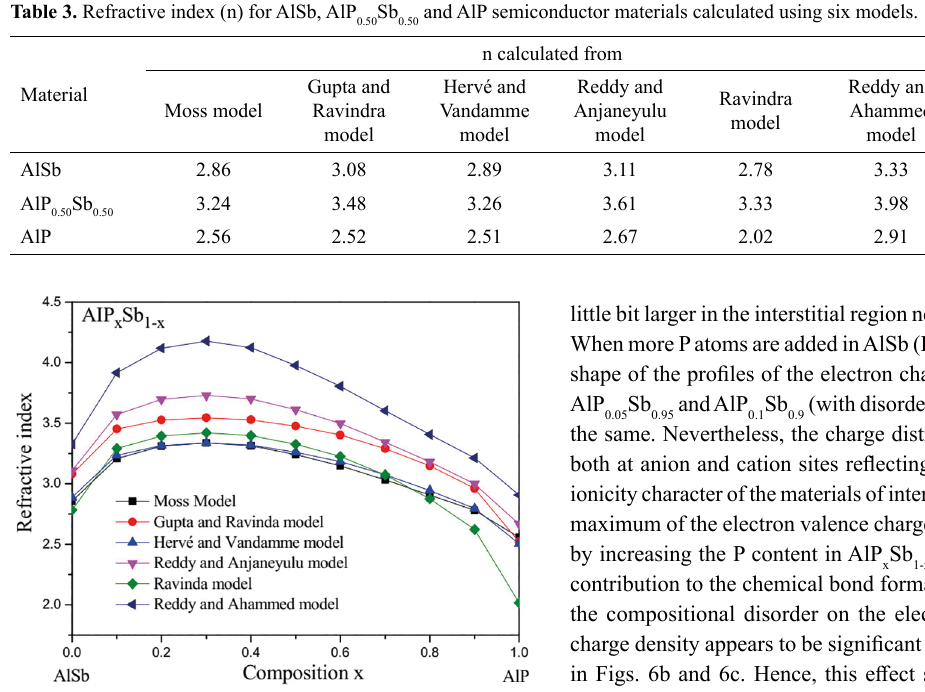
Figure 5. High-frequency dielectric constant in AlP versus P content calculated using Reddy and Anjaneyulu model 25 .